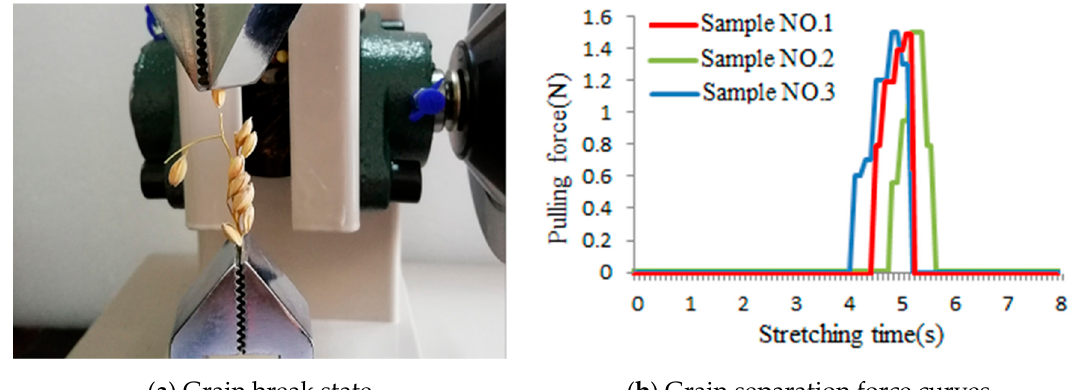
Figure 7. Rice grain break state and separation force curves.